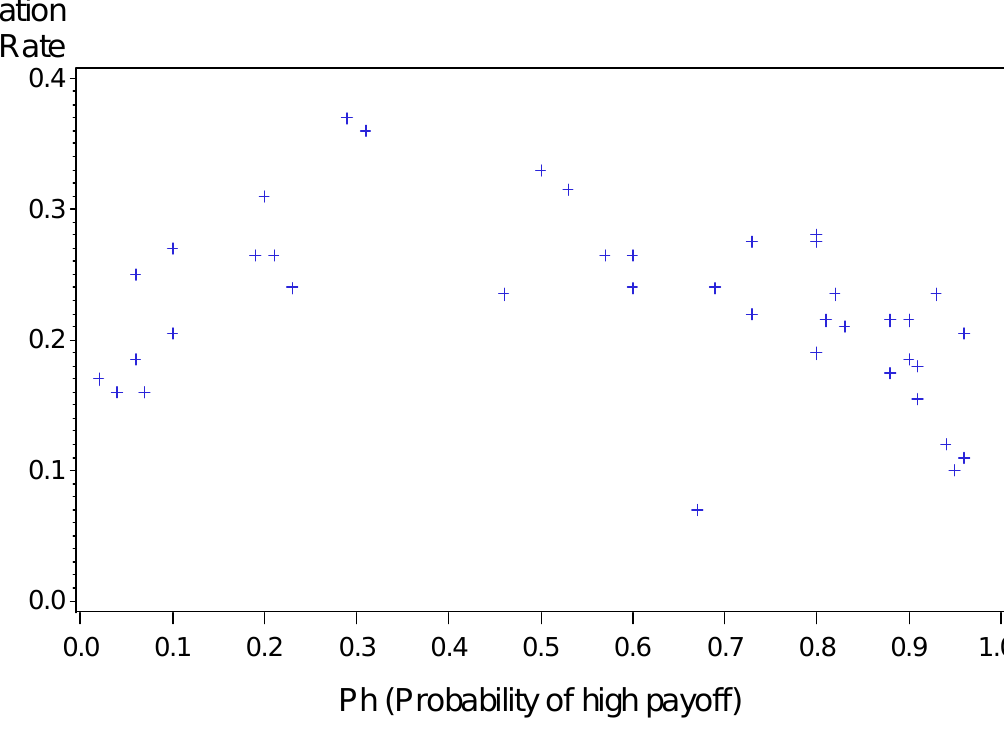
Figure 1. Proportion of alternation as a function of Ph . Each data point summarizes the results of one game. The outlier (alternation rate of 0.07 when Ph = 0.67) is Problem 3: The problem with the lowest payoff variance, and the only problem in which entry cannot lead to losses.